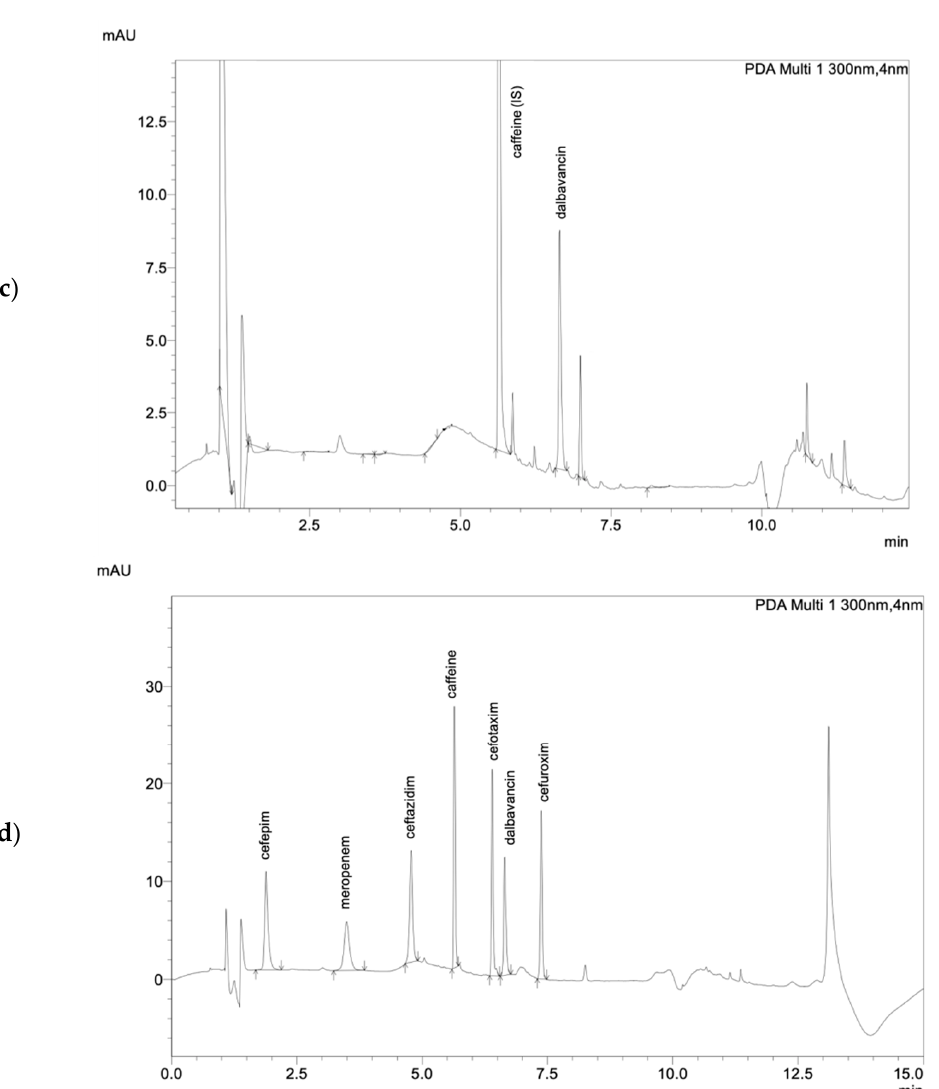
Figure 1. ( a ) Chromatogram of blank serum, ( b ) chromatogram of dalbavancin calibration standard (200 mg/L), ( c ) chromatogram of dalbavancin in patient serum and ( d ) chromatogram showing cefepime, meropenem, ceftazidime, caffeine, cefotaxime, dalbavancin, and cefuroxime.